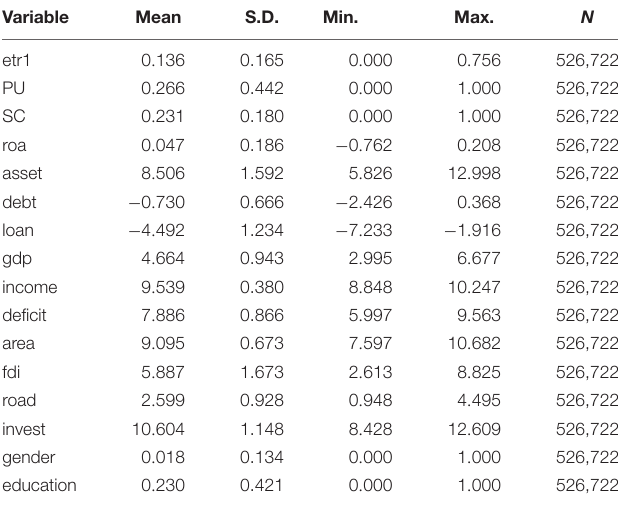
TABLE 2 | Descriptive statistics of the main